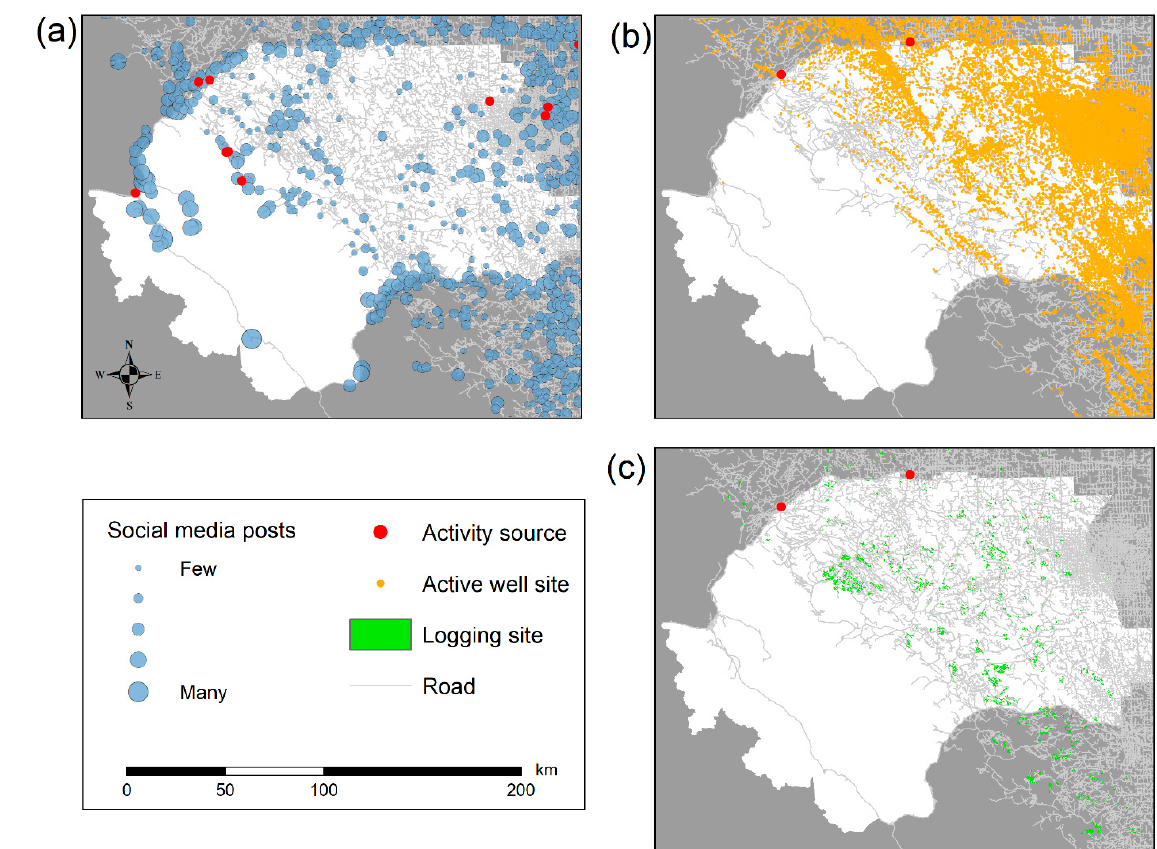
Figure 2. Maps of locations of the three types of human activity used in the network-based road-use classification: ( a ) recreation activity represented by social media posts, ( b ) oil and gas activity represented by active well sites and ( c ) recent forest logging activity detected by satellite. Activity sources represent where travelers to activity locations are likely to have originated. The activity sources and locations together represent the “nodes” used in the Circuitscape algorithm. Identification of activity sources is described in Section 2.3.1.